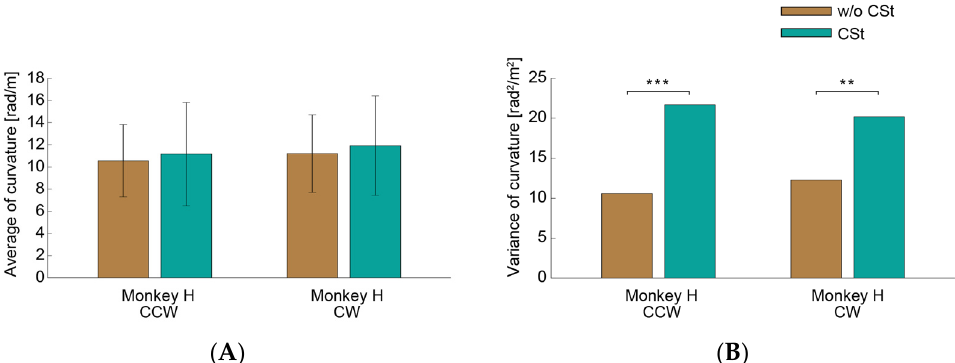
Figure 7. E ff ects of CS close to the target (CSt) on the cursor movement accuracy and precision during the circle-drawing task Monkey H are shown. They are evaluated at the cursor acceleration minimum point close to the target ( A ) Average of curvature of the cursor trajectory. An error bar represents a standard deviation. ( B ) Variance of the curvature. ** p < 0.01. *** p <